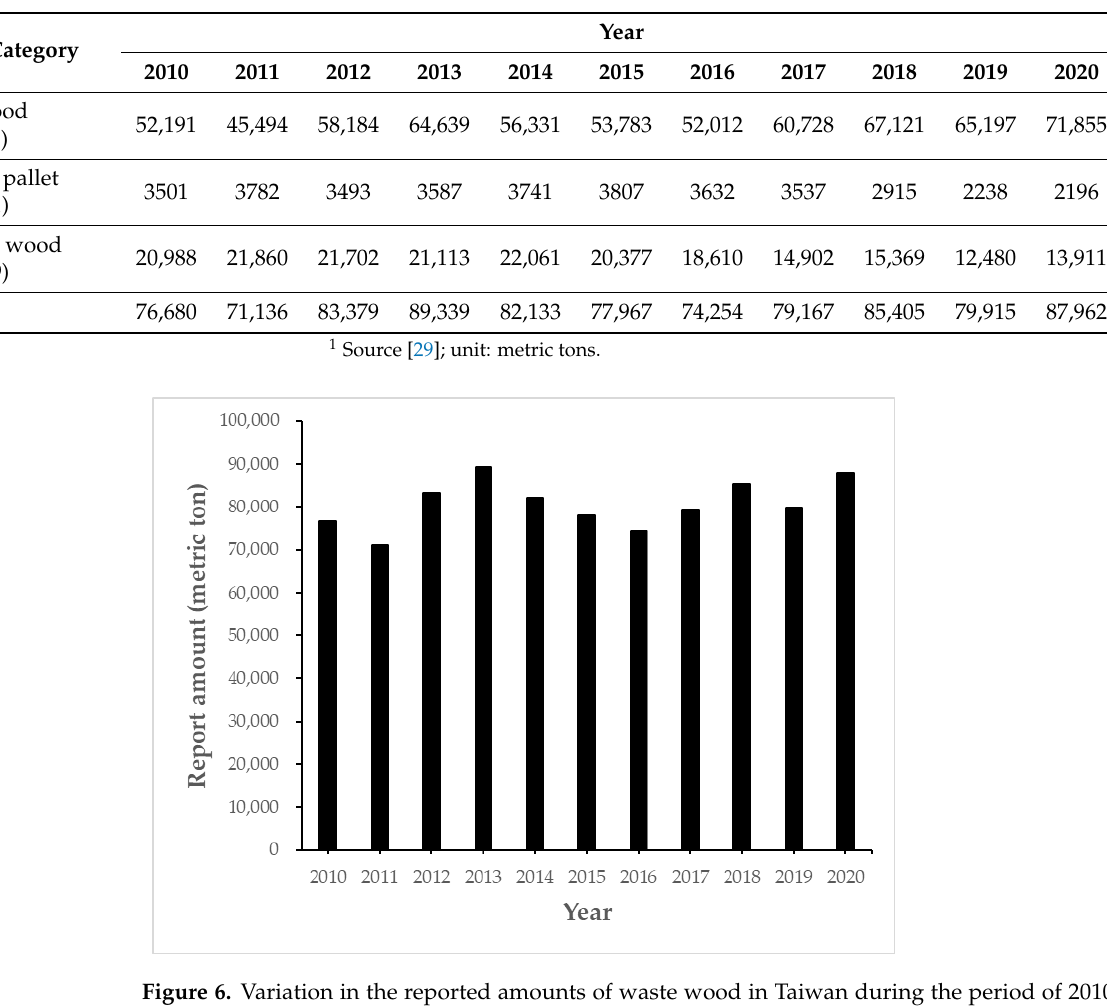
Figure 7. Feed-in tariff (FIT) rates of biomass-to-electricity in Taiwan since 2010. 4. Conclusions S ince the Kyoto Protocol was made effective in 2007, the decoupling of economic development from GHG emissions has become a core mission in governance. Although Taiwan is not a UNFCCC party, it has long been committed to fulfilling its responsibility as a member of the global community by endeavoring to take initiatives to help mitigate GHG emissions. An increase of 14.3% in the GHG emissions from the energy industries